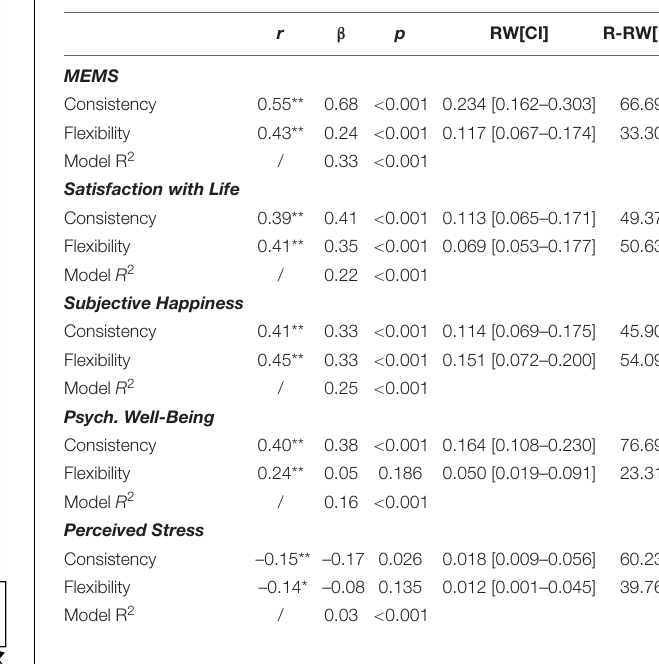
TABLE 4 | Study 2: Relationships of consistency and flexibility with theoretically related